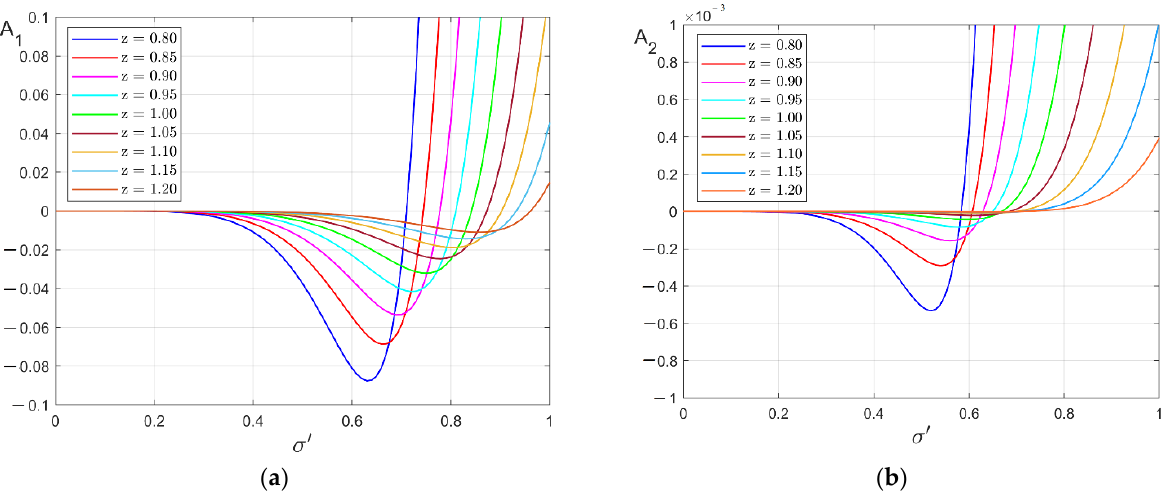
Figure 3. Plots for 𝐴 1 (𝑧′, 𝜎′) ( a ) and 𝐴 2 (𝑧′,𝜎′) ( b ) versus 𝜎′ near 𝜎 0 (𝐴 1 (𝑧′, 𝜎 0 ) = 0) at different 𝑧′ .